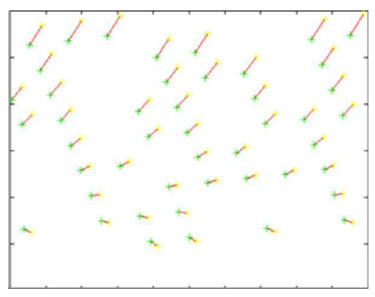
Figure 10: Image point of GCP with